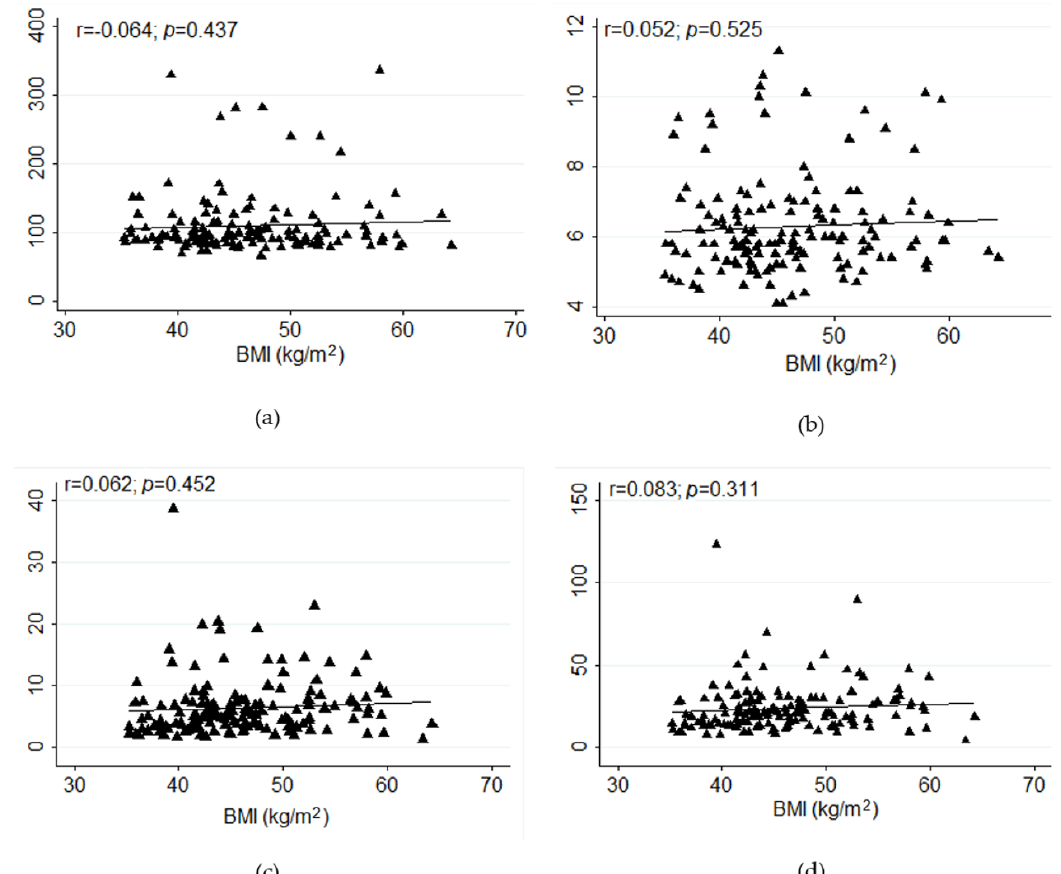
Figure 1. Correlation between body mass index and glycemic parameters in class II and III obesity (( a ). fasting blood glucose, ( b ). glycosylated hemoglobin, ( c ). homeostasis model assessment of insulin resistance, ( d ). insulin).